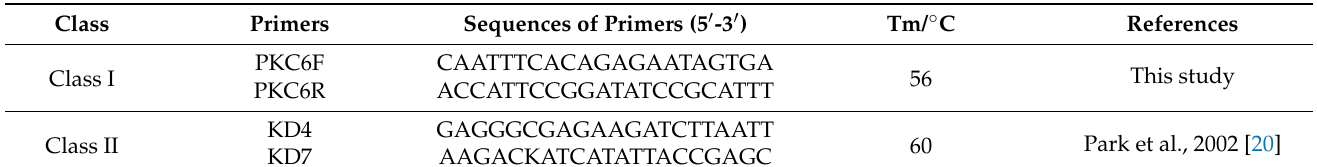
Table 3. The specific primers of SRK.